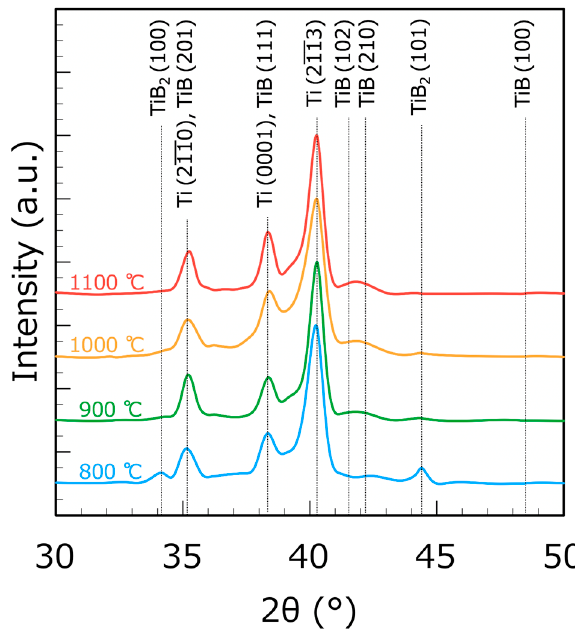
Figure 2. XRD patterns of SPS compacts (~12.5 vol.% TiB in the final composite) at each temperature.